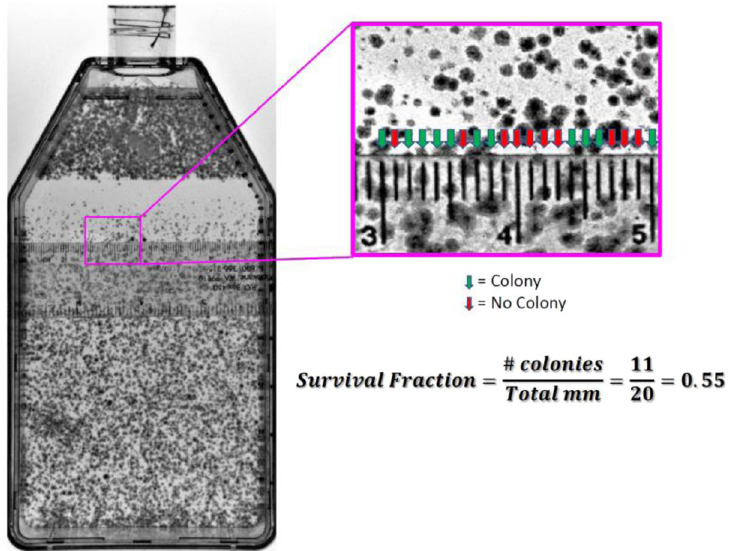
Figure 7. Example scoring procedure for calculating survival fraction. At each specified depth, surviving colony or no colony was addressed for every millimeter across the widths of the flask. Surviving colony was defined as a colony containing > 50 cells. Survival fraction was equal to the number of surviving colonies over the total width of flask